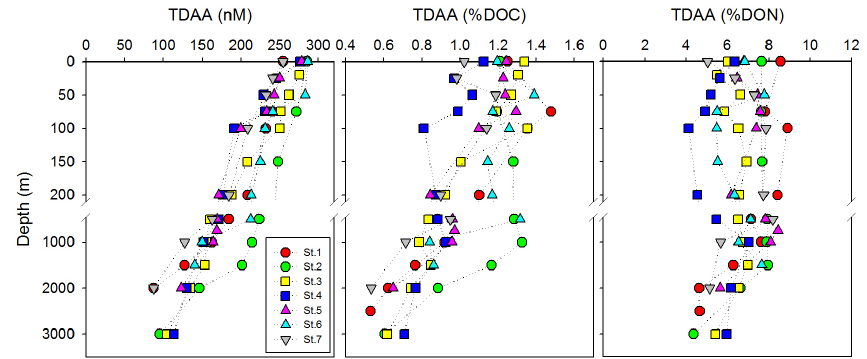
Figure 3. Vertical profiles of total dissolved amino acids (TDAAs), DOC-normalized yields of TDAAs (%DOC), and DON-normalized yields of TDAAs (%DON) in the East/Japan Sea.